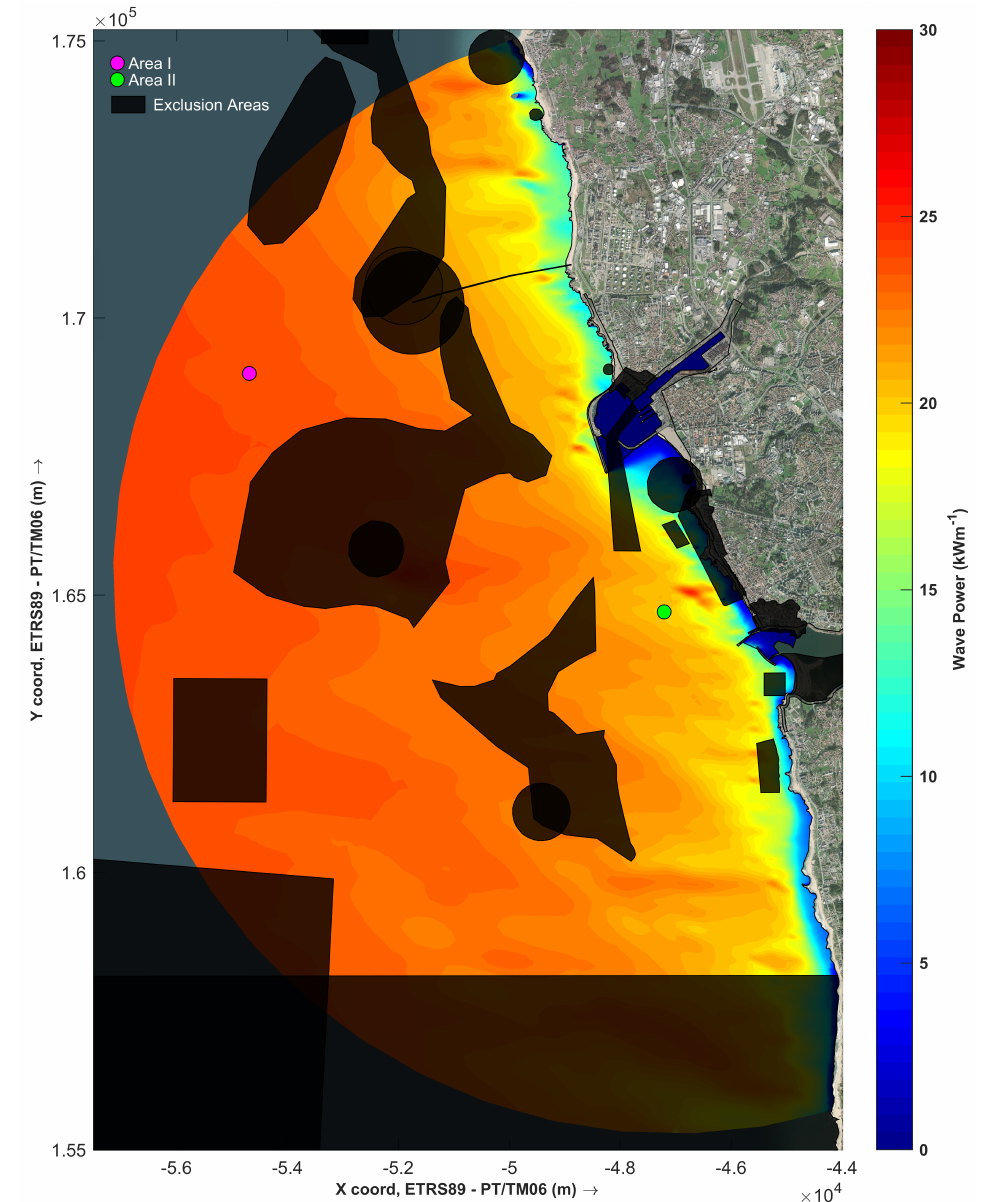
Figure 7. Example of suitable areas for the exploitation of the wave energy resource in the vicinity of Port of